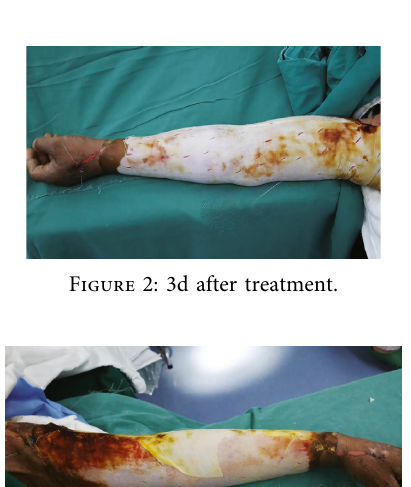
Figure 1: Prior treatment.